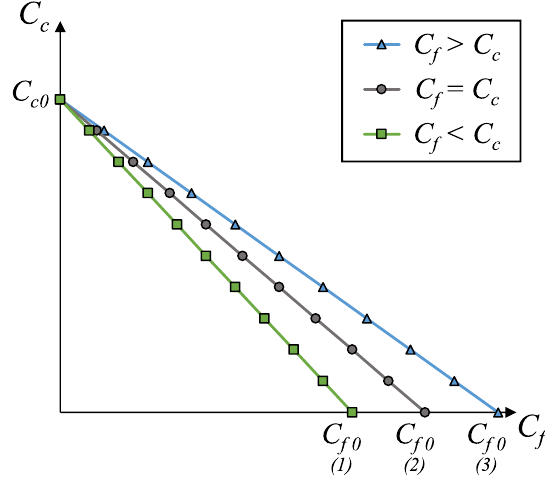
Figure 1. Graph of the relationship between fog and cloud computing